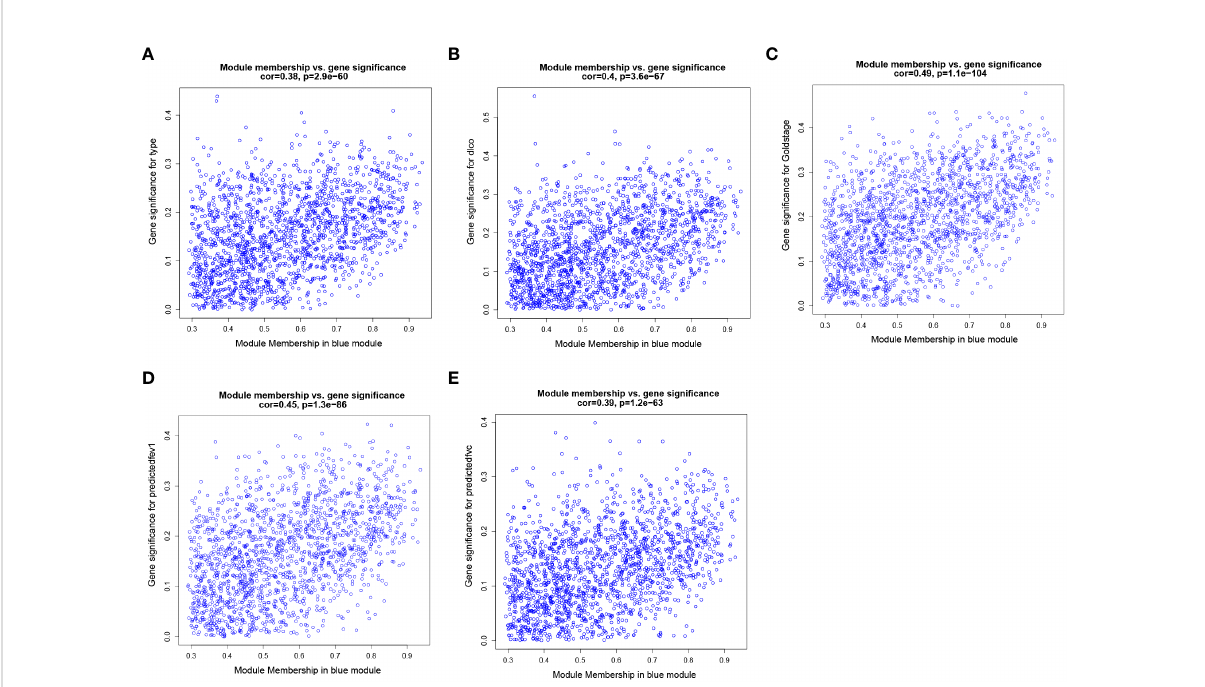
FIGURE 7 Weighted co-expression network analysis. Scatter plot of genetic signi fi cance of emphysema phenotype (A) , DLCO (B) , GOLD Stage (C) , FEV1 post-bronchodilator % predicted (D) and FVC post-bronchodilator % predicted (E) vs . Module Membership in blue module.